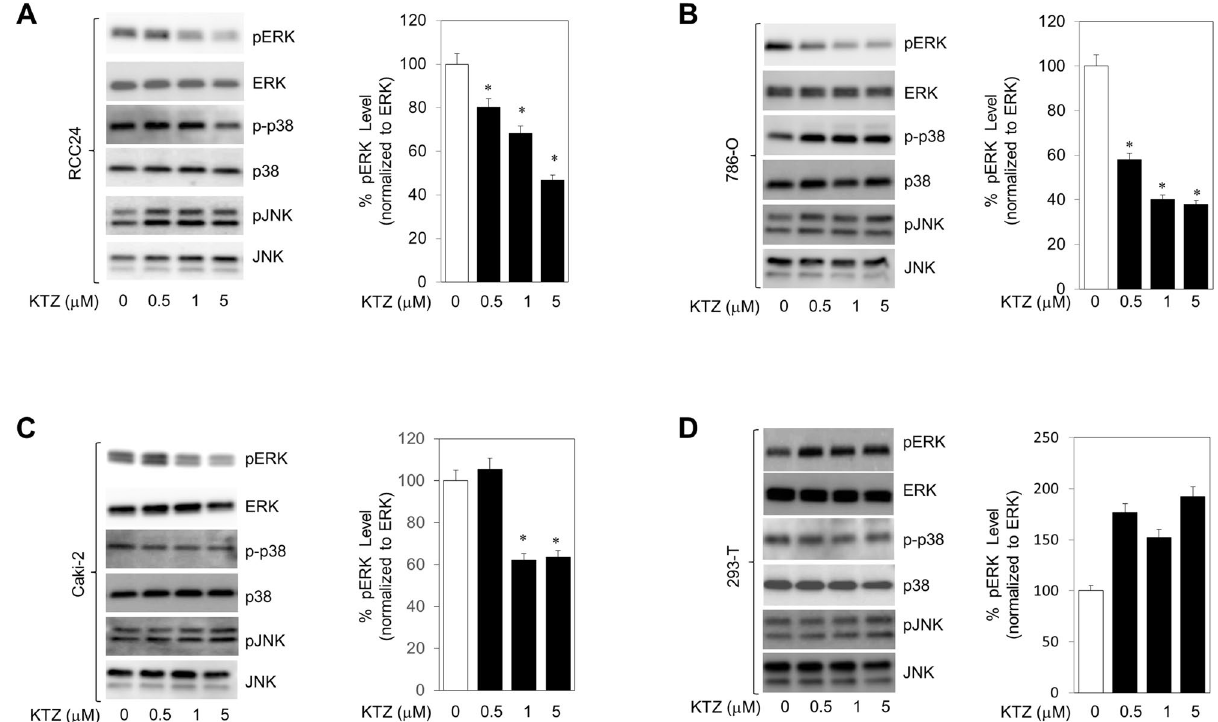
Figure 3. KTZ attenuates exosome biogenesis and secretion through inhibition of the ERK signaling pathway in RCC cells. KTZ significantly inhibited activation p-ERK (downstream effector molecule of the ERK signaling pathway) but not p-p38 or p-JNK in RCC-24 ( A ), 786-O ( B ), and Caki-2 ( C ) cells. Ketoconazole significantly increased activation p-ERK in 293-T ( D ) cells. Full blots are presented in Supplementary Fig. S6. Mean values and standard errors were derived from four independent experiments. *Denotes significance at p < 0.05 compared to controls and was calculated using GraphPad